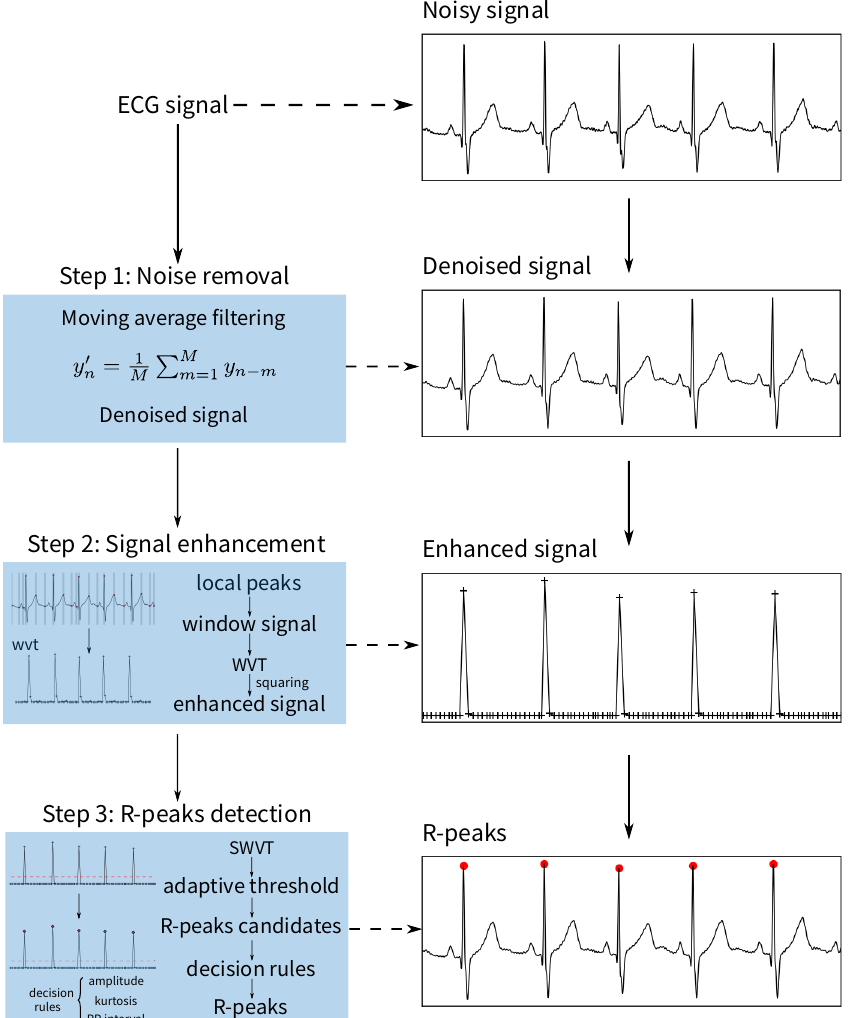
Figure 2. Flowchart of the proposed method. WVT—window variance transform